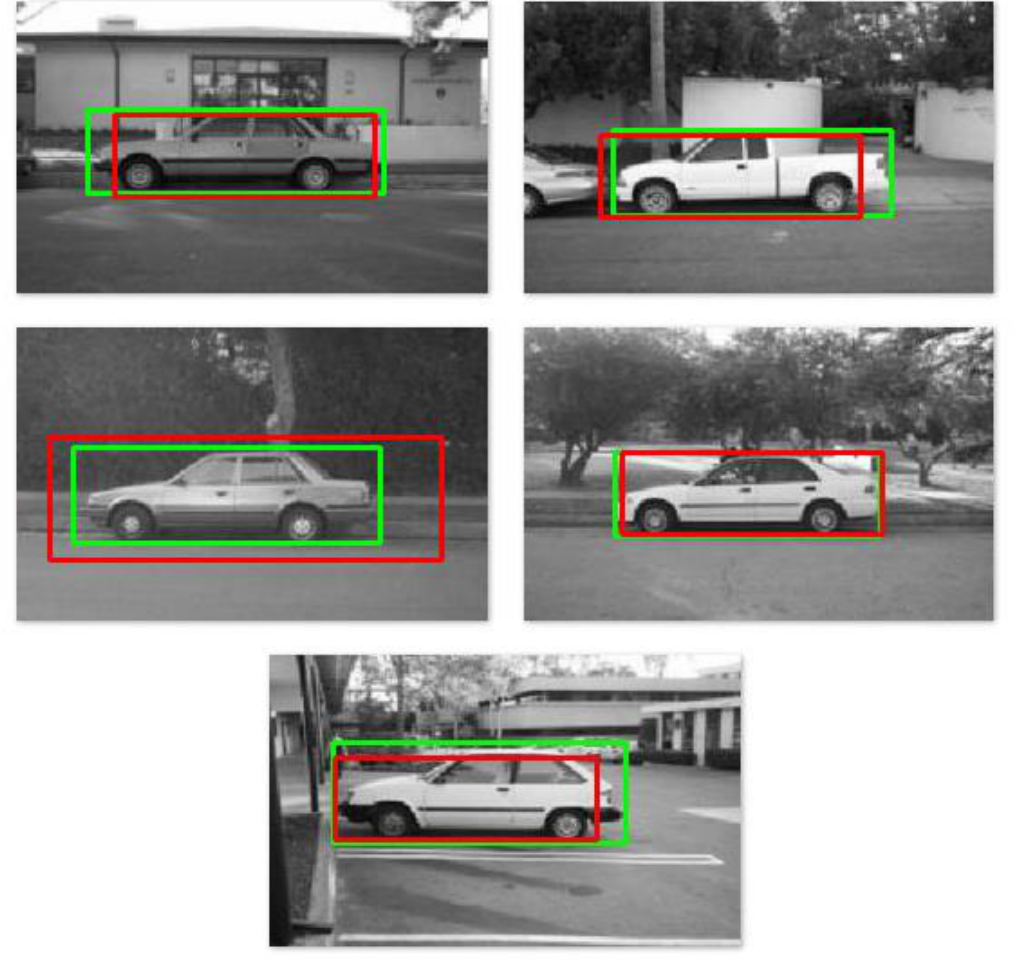
Figure 2. Obtained figure using Haar Cascade